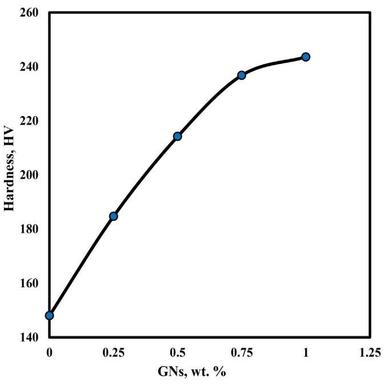
Macro hardness of Cu/WC-TiC-Co/GNs nano-composites as a function of graphene percent.